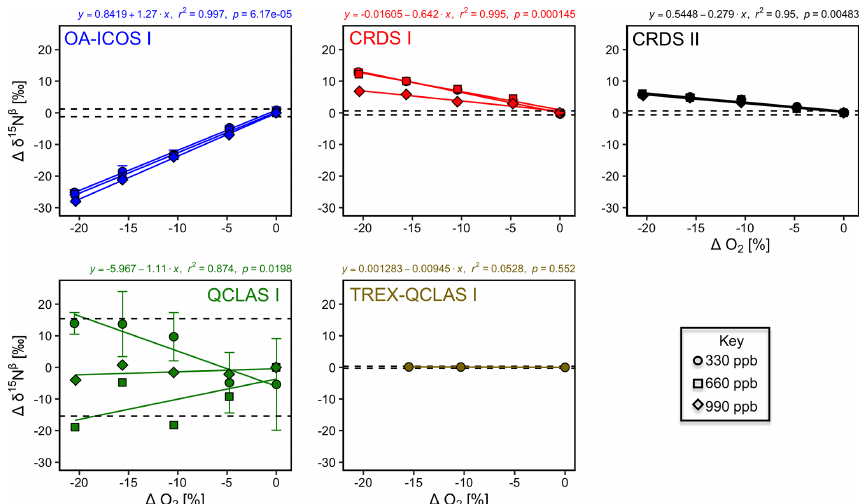
Figure 6. Deviations of the measured [ N 2 O ] , δ 15 N α , δ 15 N β and δ 18 O values according to (cid:49) O 2 (%) at different N 2 O mole fractions (330, 660 and 990ppb) for the OA-ICOS I (blue), CRDS I (red), CRDS II (black), QCLAS I (green) and TREX-QCLAS I (brown). The remaining plots for [ N 2 O ] , δ 15 N α and δ 18 O are provided in Sect. S4 (Fig. S4-4). The standard deviation of the Anchor gas ( ± 1 σ ) is indicated by dashed lines. Data points represent the mean and standard deviation (1 σ ) of triplicate measurements. Dependencies are best described using linear regressions, which are indicated by a solid line. Individual equations, coefficients of determination ( r 2 ) and p values are indicated above each plot for the 330ppb N 2 O data